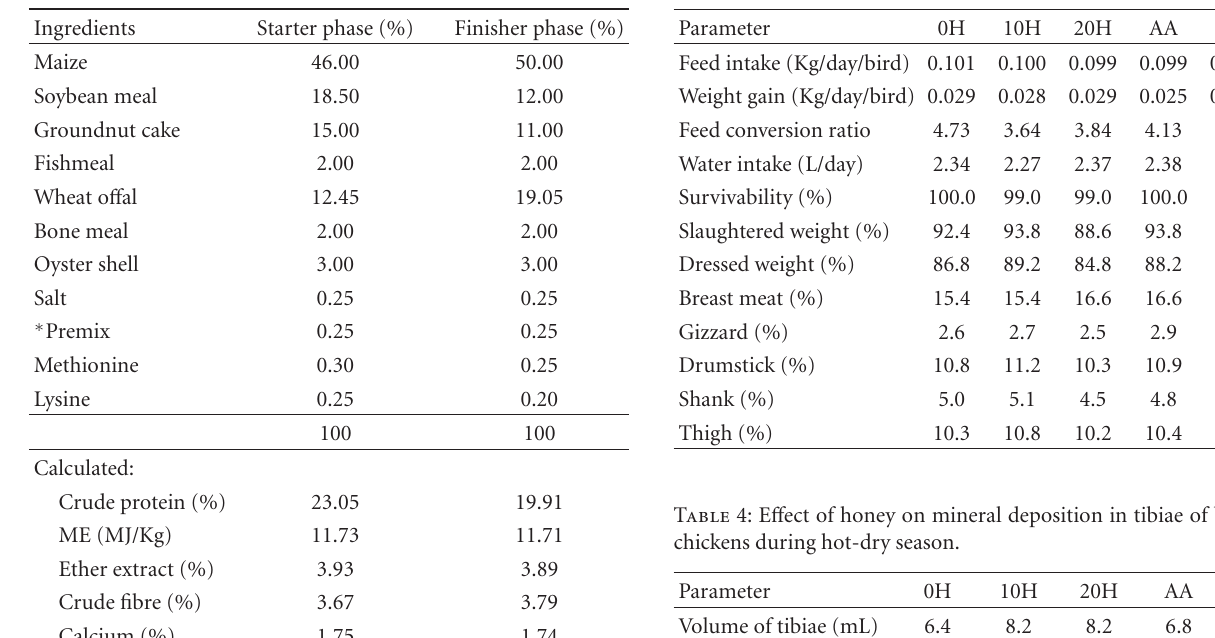
Table 1: Composition of diets for broiler (starter and finisher phases).